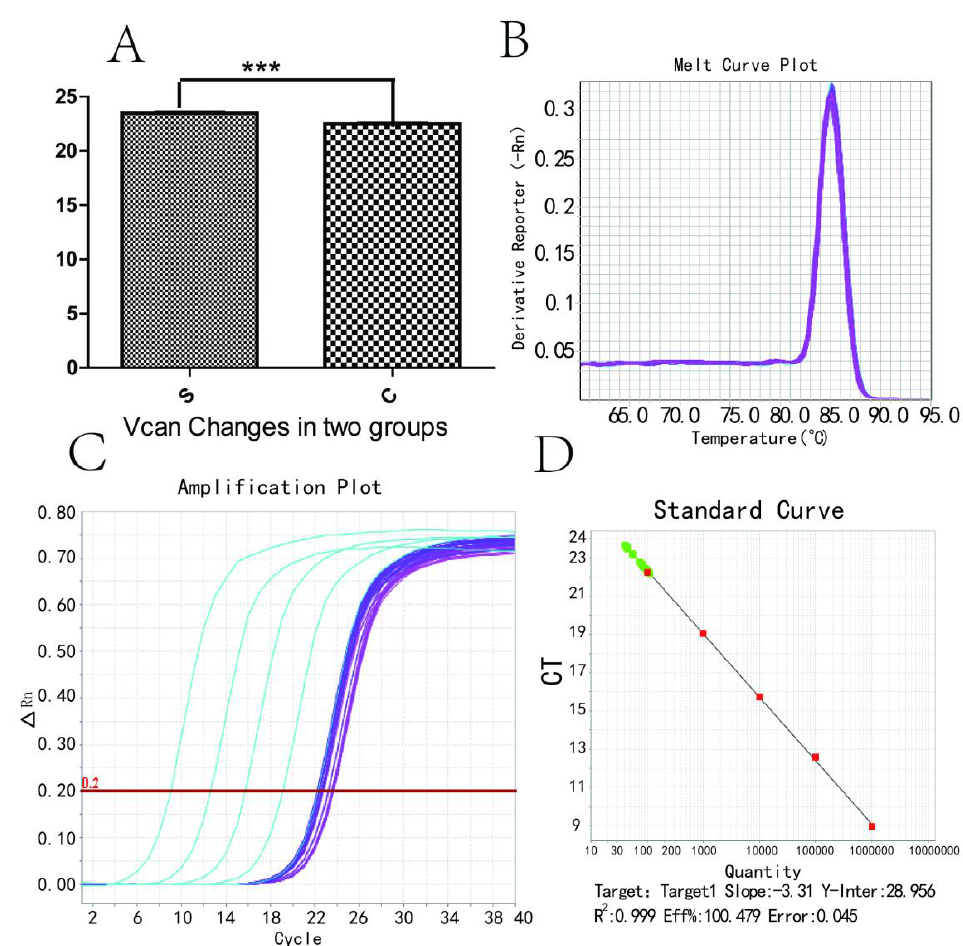
Figure 4. Vcan gene RT-PCR changes, including melting, amplification and standard curves. ( A ) RT-PCR changes of the Vcan gene; ( B ) melt curve plot Vcan; ( C ) amplification plot Vcan, a curve made with the number of cycles as the abscissa and the real-time fluorescence signal during the reaction as the ordinate. The amplification curve is generally divided into baseline period, exponential growth period and plateau period. ( D ) standard curve Vcan. Values are the mean ± SD of triplicate experiments and analysed using ANOVA with Tukey post hoc tests. *** p < 0.001 compared to the control group.